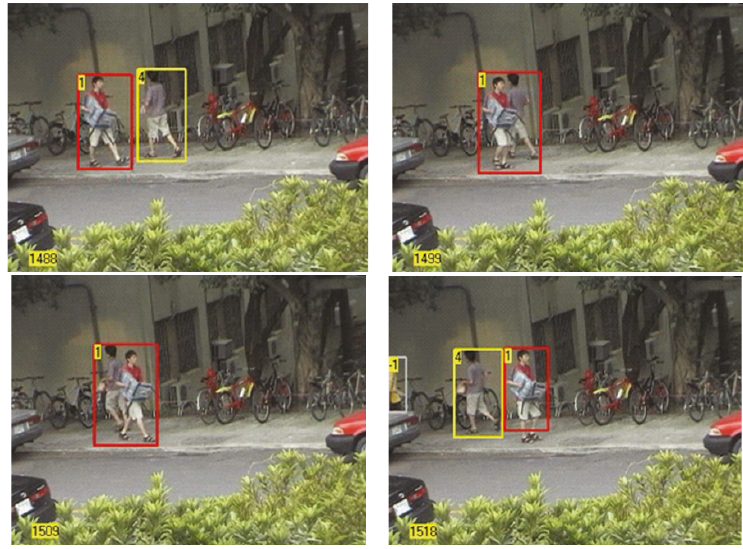
Figure 19: The results in human tracking—Environment 1.